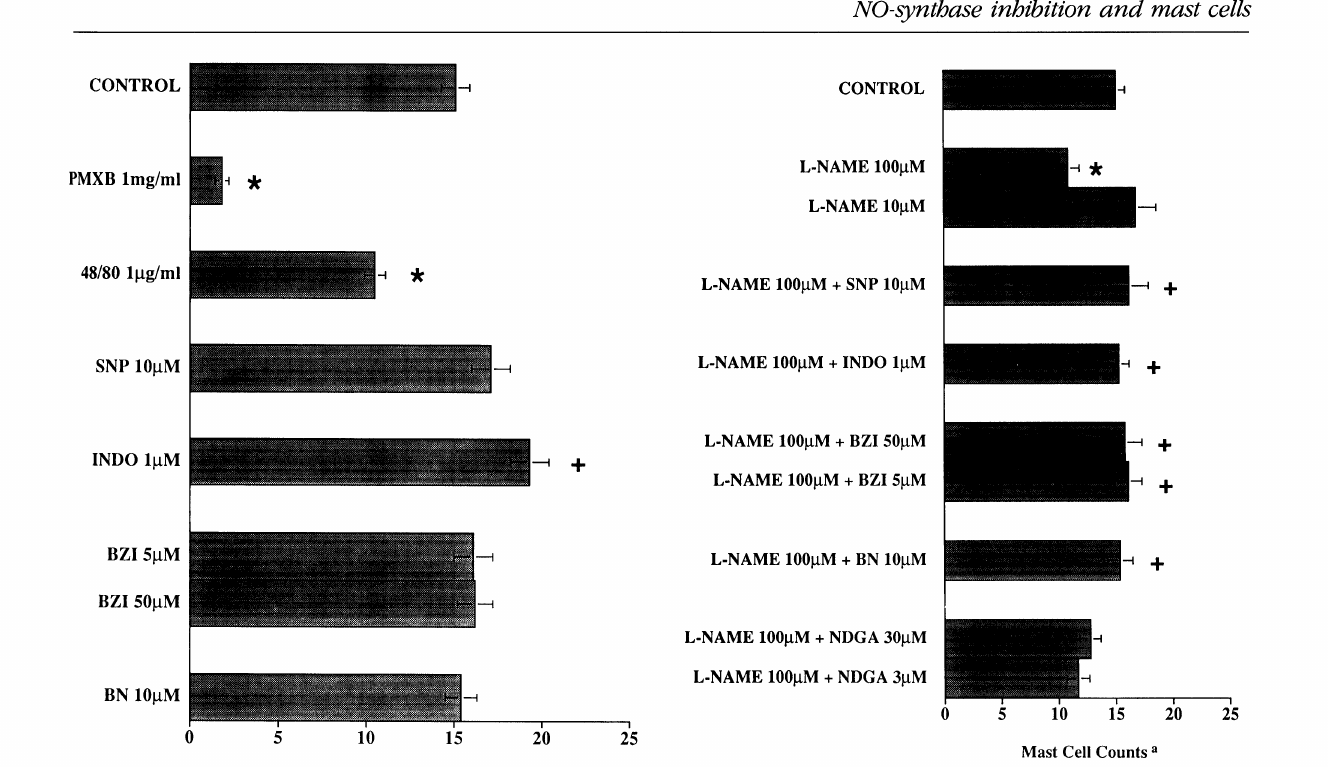
FIG. 1. Effects of various agents on the degranulation of rat omental mast cells, aMast cell counts are the mean numbers -t- SEM of metachromatically stained mast cells per omental milky spot. *lower than, +higher than the control value (p < 0.05, Bonferroni’s test). Abbreviations not used in the text: INDO, indo- methacin; BN, BN52021.